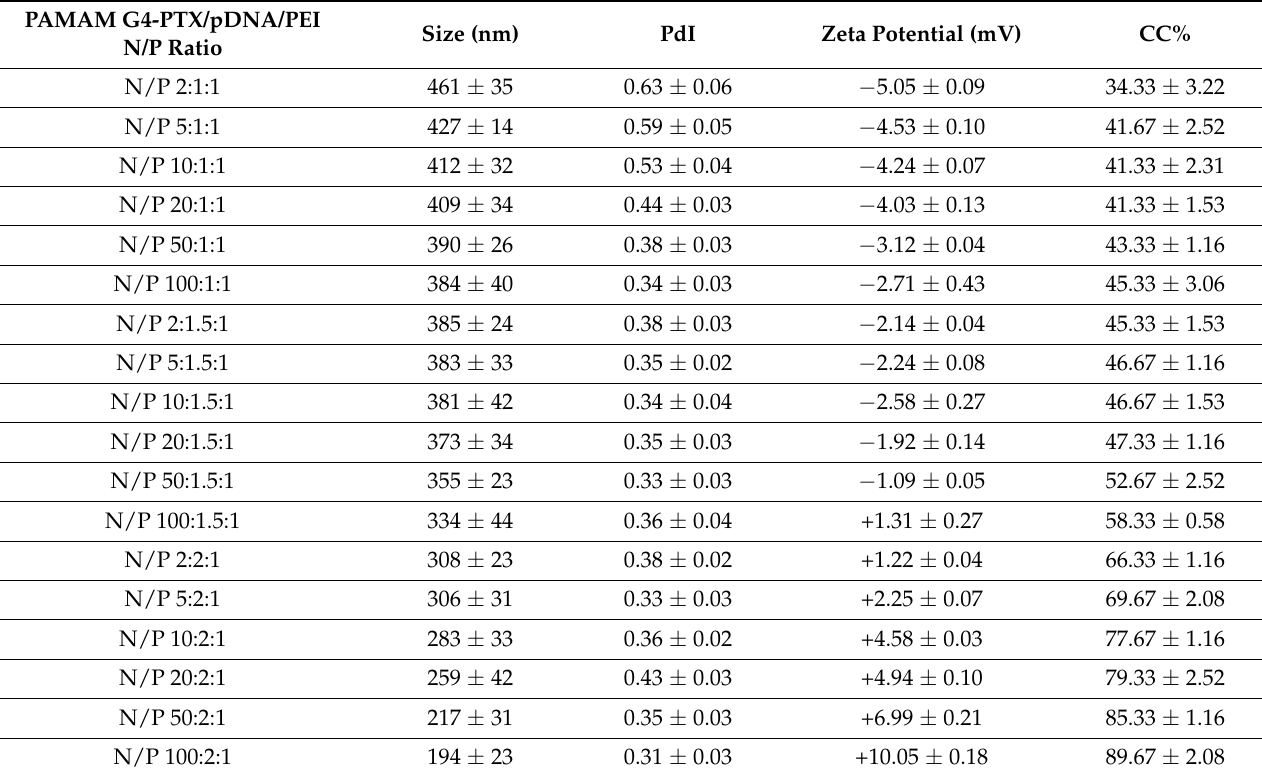
Table 1. Mean size, polydispersity index (PdI), average zeta potential and pDNA complexation capacity (CC) for PAMAM G4-PTX/pDNA/PEI complexes formulated at several N/P ratios. The values were calculated with the data obtained from three independent measurements (mean ± SD, n =